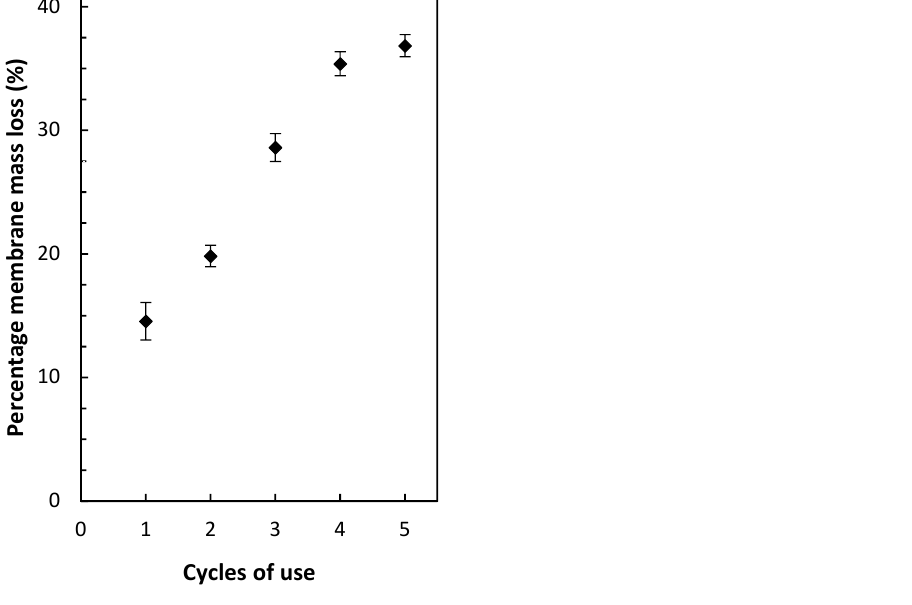
Figure 11. AFM three dimensional topographic images of the surface of ( a ) the blank PVD-HFP film and ( b ) the optimized PIM consisting of 50 wt% PVDF-HFP, 40 wt% Aliquat ® 336 and 10 wt% DBP.